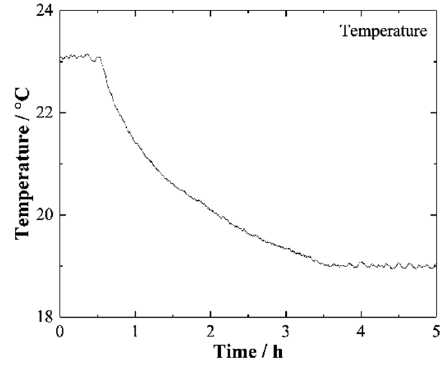
Figure 9. Temperature in the chamber.